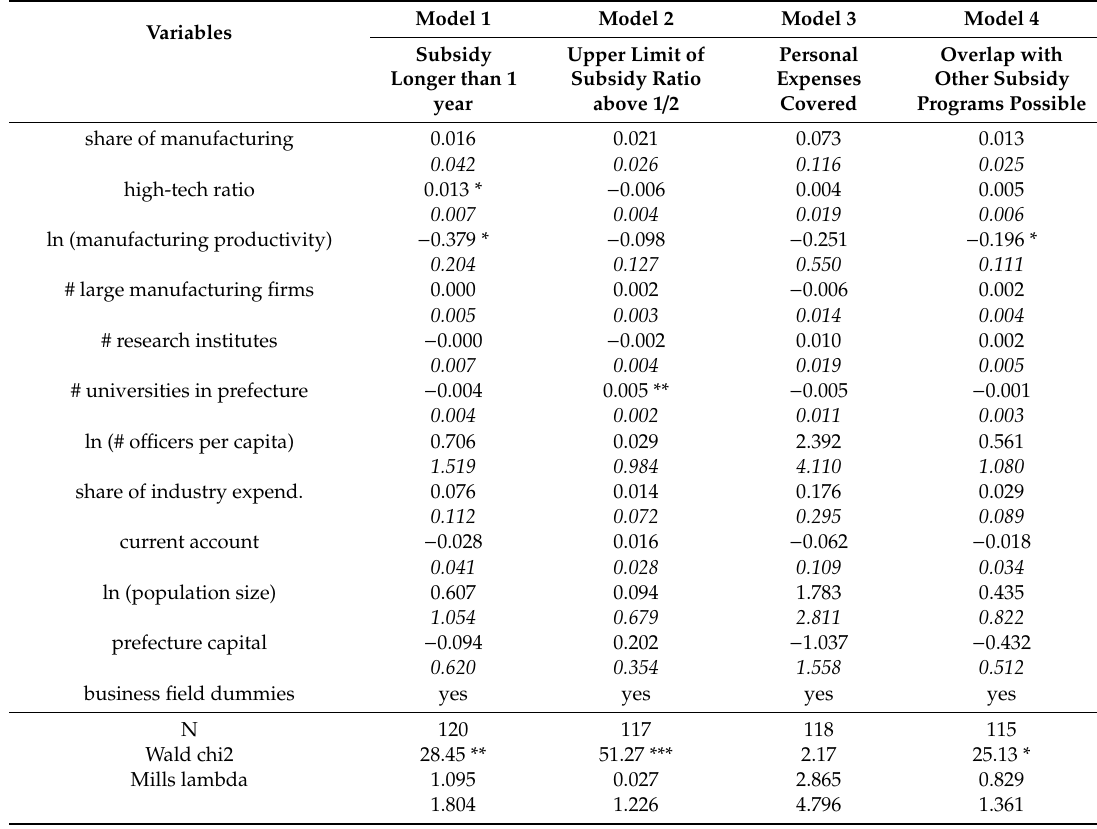
Table 7. Heckman’s sample selection